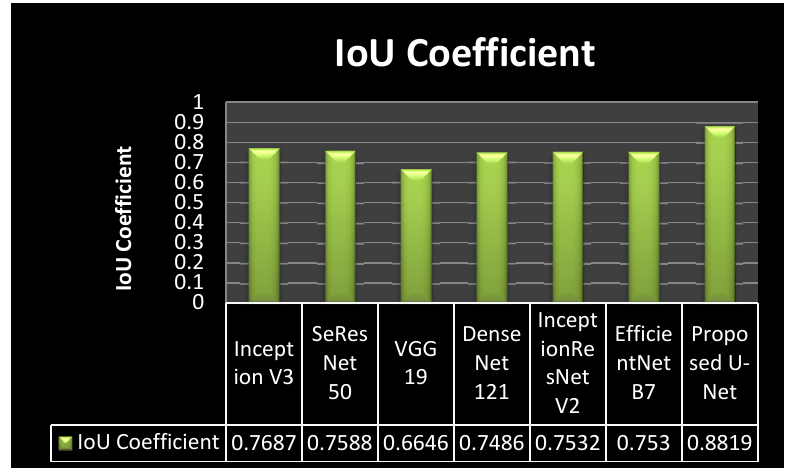
Figure 13. IoU Coefficient Comparison Graph.